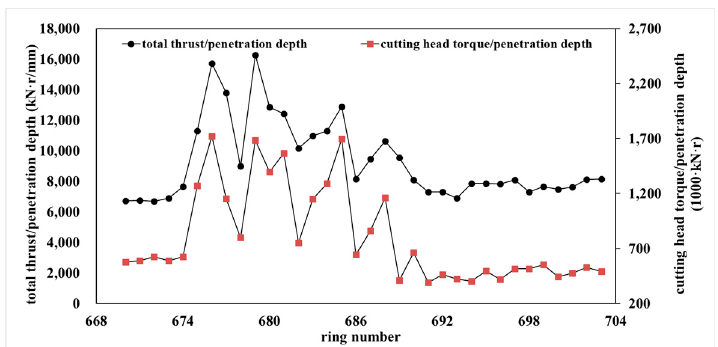
Figure 12. Changes of the two composite parameters at the Jinan Huanghe River Crossing tunnel construction.